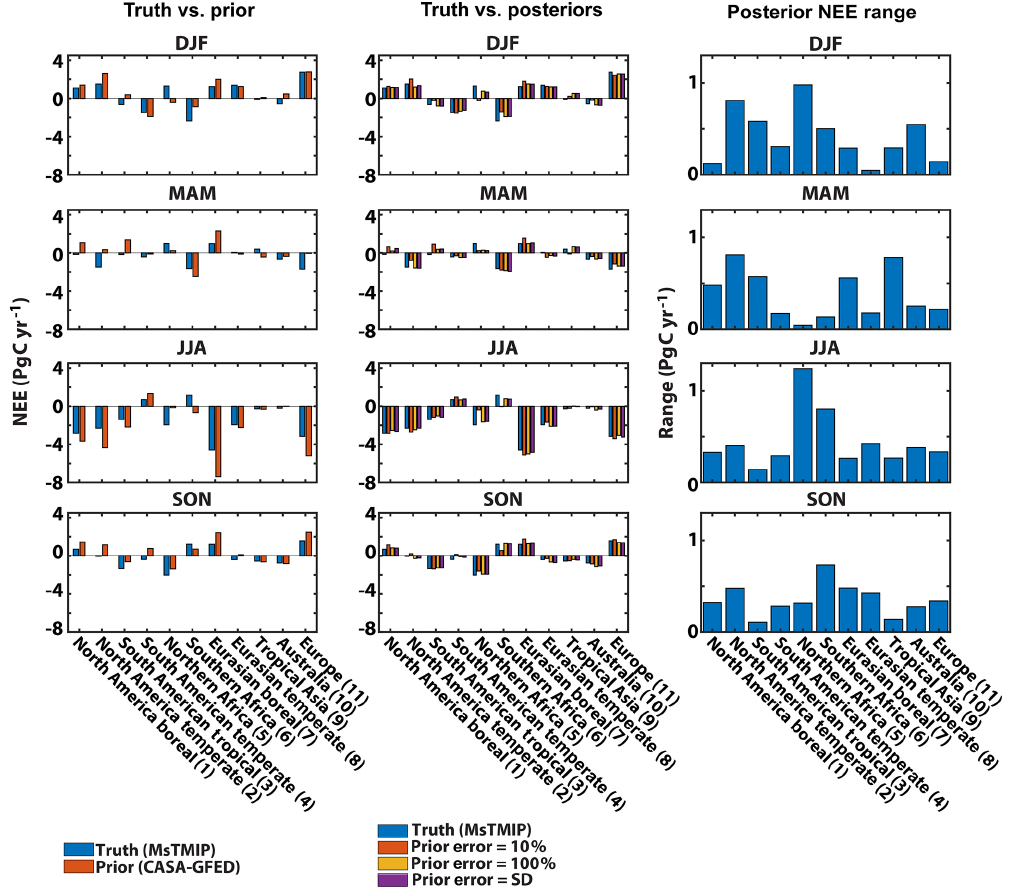
Figure 7. Seasonally averaged NEE averaged over the 11 TransCom-3 land regions from MsTMIP (truth) vs. CASA-GFED prior biosphere model (left column), posterior estimates with the three different prior uncertainties (middle column), and the corresponding range of posterior NEE (right column). The synthetic observations in OSSE simulations correspond to the OCO-2 LN + LG observing modes. Detailed statistics of the truth, prior, multi-model mean of posterior NEE estimates, standard deviations (SD), and ranges displayed in this figure are listed in Table S1 in the